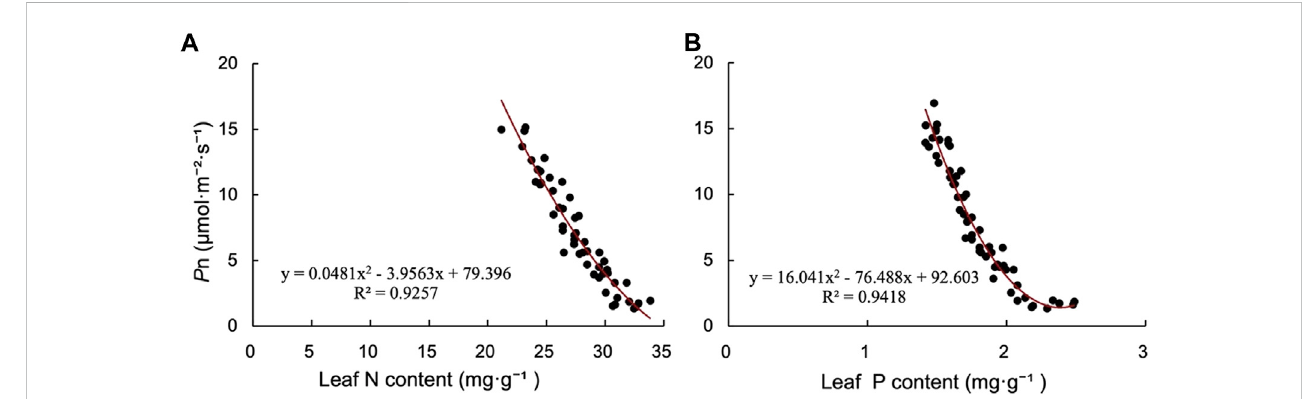
FIGURE 6 Relationship between photosynthetic rate and (A) total N and (B) total P in P.tanacetifolia leaves.